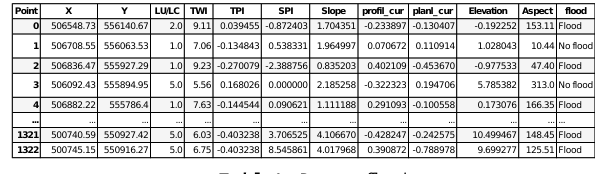
Table 1 : Dataset